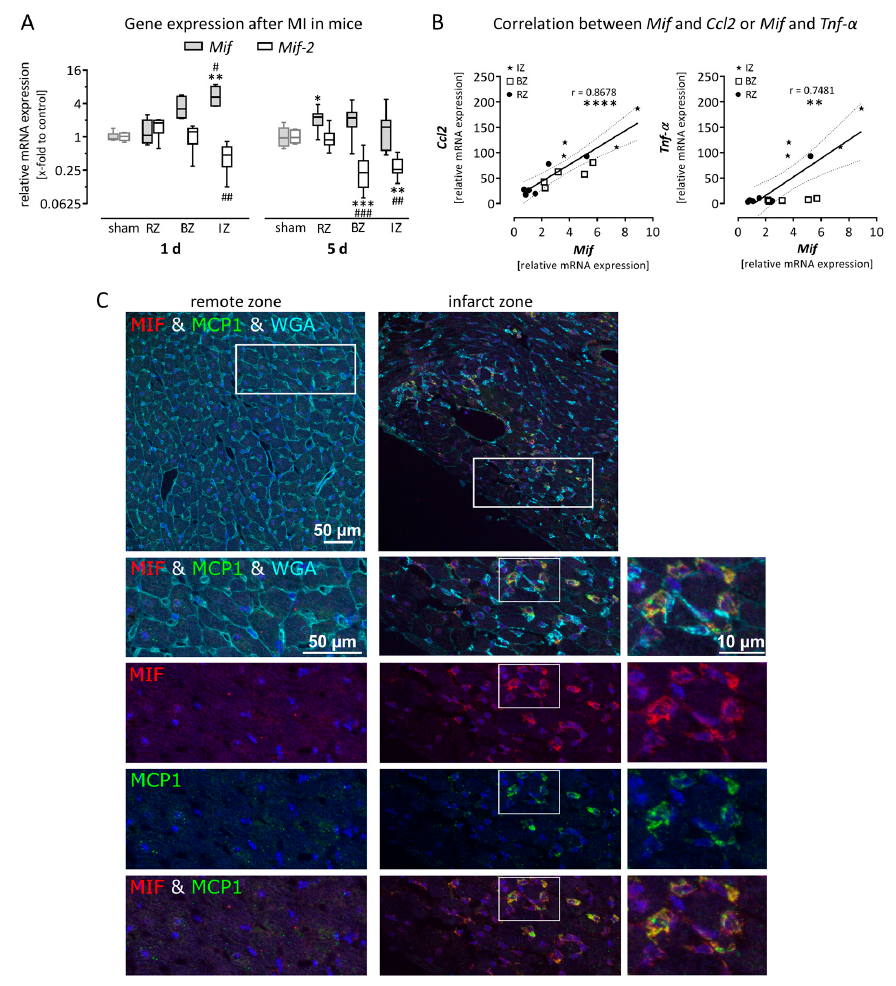
Figure 1. Mif and Mif-2 expression is oppositely regulated in mice after Myocardial infarction (MI). ( A ) MI was induced in mice by permanent coronary ligation. Gene expression of Mif and Mif-2 was quantified in left ventricular (LV) tissue samples collected from the remote zone (RZ), border zone (BZ) and infarct zone (IZ). Gene expression in the IZ was oppositely regulated for the two genes. While Mif was significantly increased during the acute phase (1 day) after MI, Mif-2 gene expression was significantly decreased. However, 5 days after MI, Mif gene expression returned to basal levels, whereas Mif-2 expression remained decreased. ( B ) Gene expression of Ccl2 and Tnf- α was quantified in LV tissue samples collected 1 day after MI. Gene expression of Mif is plotted on the x-axis while Ccl2 and Tnf- α are plotted on the y-axis. Data collected from the IZ are shown as an asterisk, from the BZ as open squares and from the RZ as filled circles. Mif expression highly correlated to the expression of Ccl2 and Tnf- α . ( C ) Immunofluorescent staining of the RZ and the IZ of a cross section 1 day after MI is shown. The WGA staining was used to visualize the structural integrity of cardiac tissue and revealed a disarranged myocardial architecture within the IZ. Protein expression of MIF (red) and MCP-1 (green) are visible at higher magnifications. While no MIF expression and very low MCP-1 expression were determined in the RZ, both cytokines are highly expressed in the IZ. Furthermore, the overlay of the co-staining (yellow) revealed that both cytokines are co-localized in the same cells. Gene expression levels are shown as relative mRNA expression (x-fold to sham operated mice) using the formula 2 −ΔΔ Ct and presented in box plots (min to max). Gene expression data represent 6–8 sham operated mice and 5–11 mice with MI. Scale bar represents 50 µm or 10 µm. * significantly different compared with sham operated mice. * p < 0.05; ** p < 0.01; *** p < 0.001; **** p < 0.0001; # significantly different compared with remote zone, # p < 0.05; ## p < 0.01; ### p < 0.001.